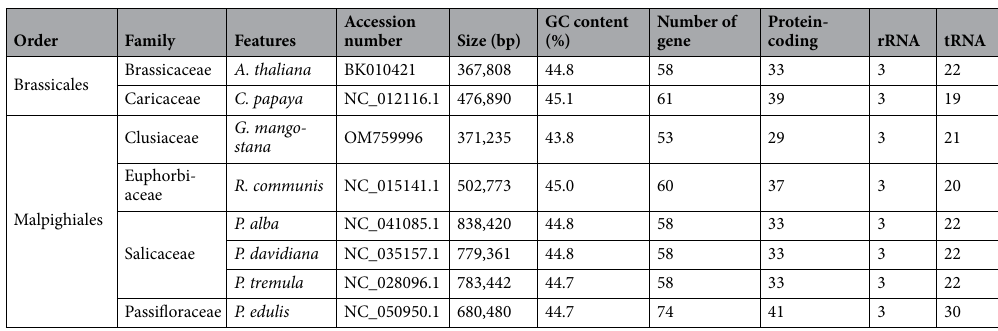
Table 1. Comparison of the gene content in mitogenomes of different